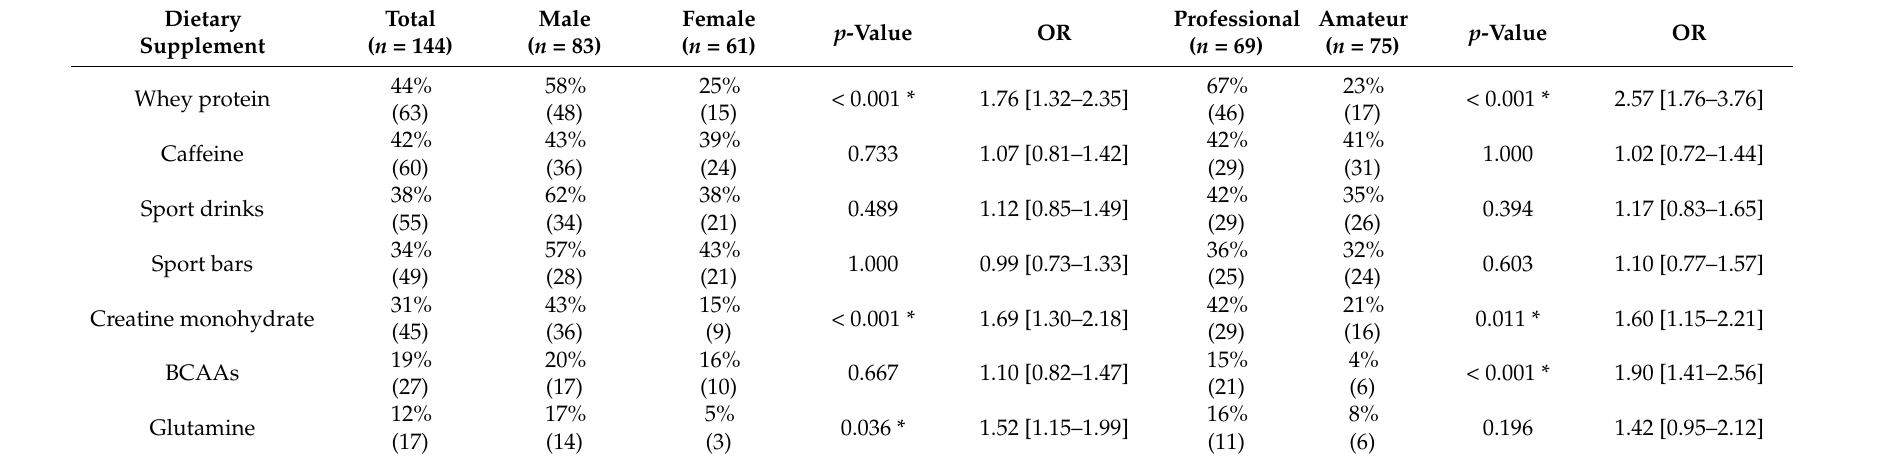
Table 2. Dietary supplements with a higher consumption divided by sex and level of